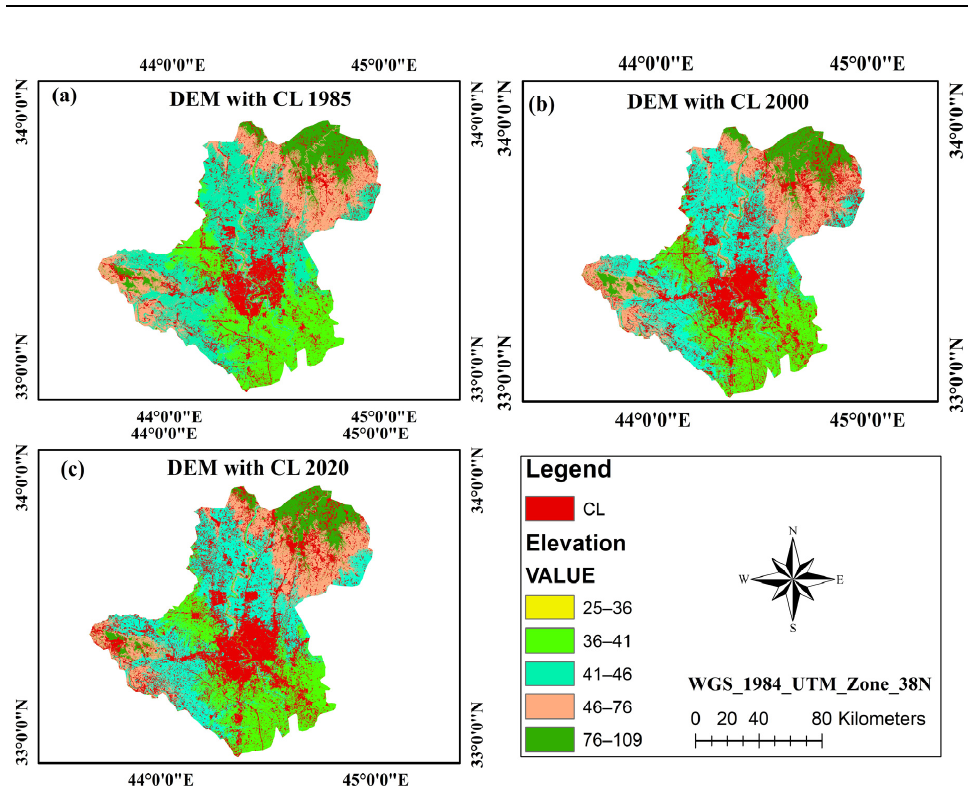
Figure 9. Influences of DEM to urban CL distributed from 1985 to 2020. ( a ) DEM with CL 1985, ( b ) DEM with CL 2000, and ( c ) DEM with CL